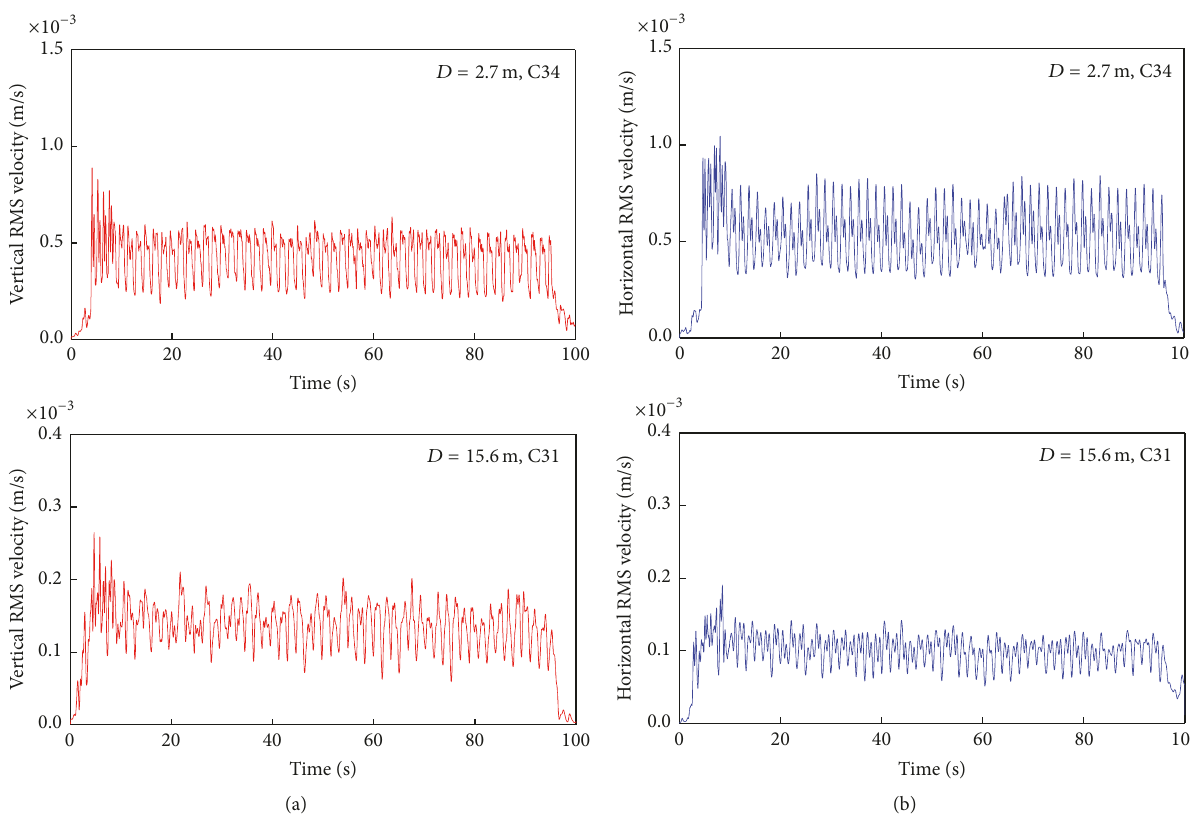
Figure 7: Running rms velocities of vertical (a) and horizontal (b) ground vibration at measuring points C34 and C31 due to the passage of T32 at speed of 28